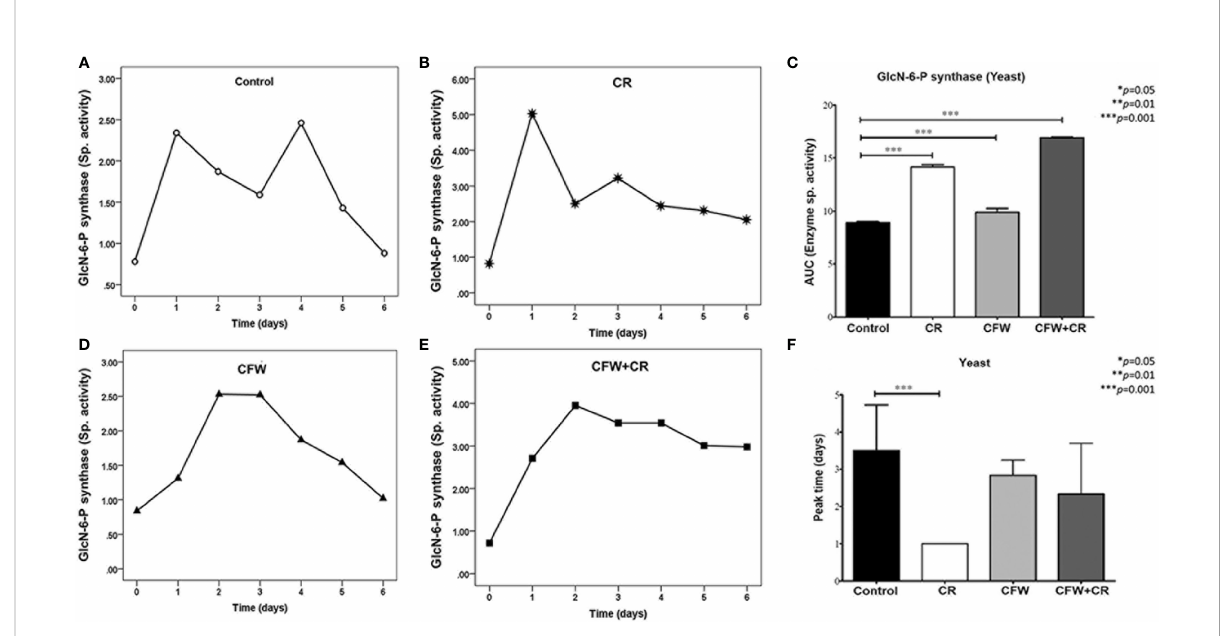
FIGURE 9 Responses of GlcN-6-P synthase from yeast cells of S. globosa to CW damage induced by CR and CFW. Yeast cells were propagated in the absence and the presence of the dyes either alone or in combination. After the indicated times, cells were processed to measure enzyme activity. Control culture and those containing CR, CFW and the mixture are illustrated in Figures (A – D) respectively. Statistics analyses were carried out by calculating the area under the curve (AUC) (E) and the time required for the enzyme to reach its maximum activity (F) . Reproduced from Ortiz-Ramirez et al., 2021 with permission from Springer Nature, License Number 5315470121400 (May 24,